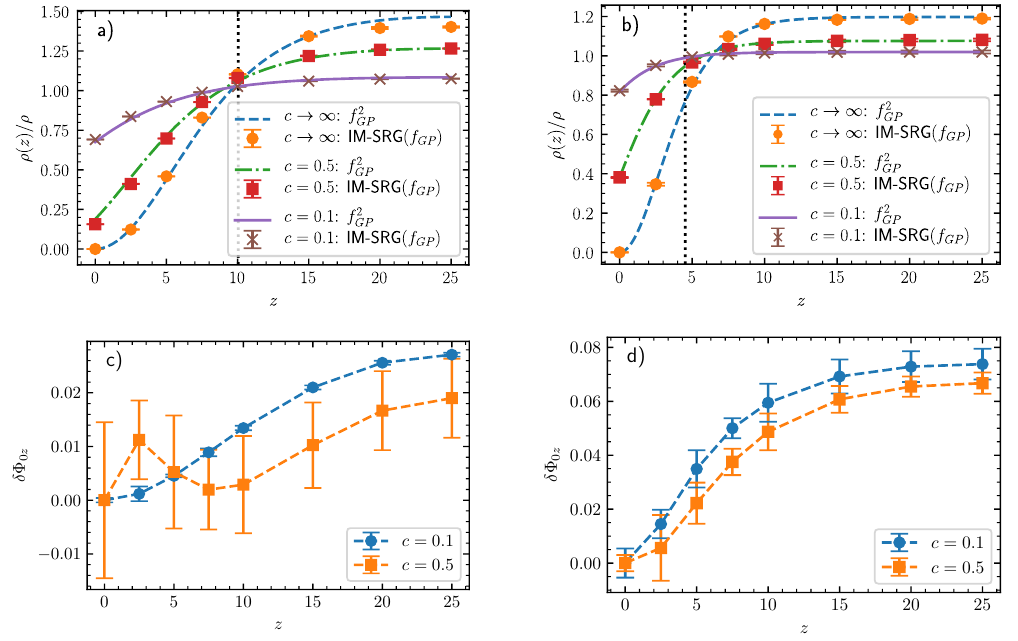
Figure 4: (Upper row): The density of the Bose gas in the frame co-moving with the impurity. Dots are calculated using the IM-SRG( f ) method. Mean-field densities GP are shown using solid, dashed and dot-dashed curves. The dotted vertical line indi- (cid:112) κ . Results are presented for N = 50, m = 1 cates the relevant healing length ξ/ and different impurity-boson interactions c listed in the legend. (Bottom row): Phase fluctuations for the Bose gas in the frame co-moving with the impurity. Dots with er- ror bars are calculated using the IM-SRG( f ) method. The dashed curves are added GP to guide the eye. The parameters N and m are as in the upper row. The boson-boson interaction strength in panels a) and c) is γ = 0.02, while in b) and d) it is γ = 0.1. γ is small 5